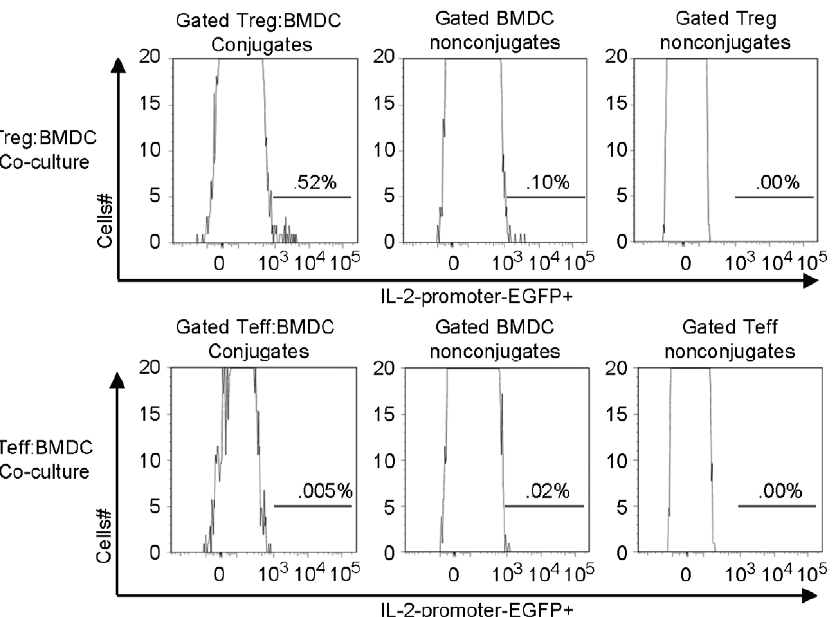
Figure 4. IL-2-producing dendritic cells form conjugates with Treg cells. BMDCs were transfected with IL-2 reporter plasmid (pIL2P8.4-EGFP) or control plasmids and analyzed for IL-2-promoter activity in cells as in materials and methods. pIL-2P8.4-EGFP-transfected C57BL/6 BMDCs were cultured with DO11.10 Treg cells or DO11.10 CD4 + CD25 2 Teff cells for 40 h. Panels show histograms of the level of IL-2-promoter-EGFP + activity in gated populations: DCs conjugated with Treg or Teff cells, and non-conjugated cells.